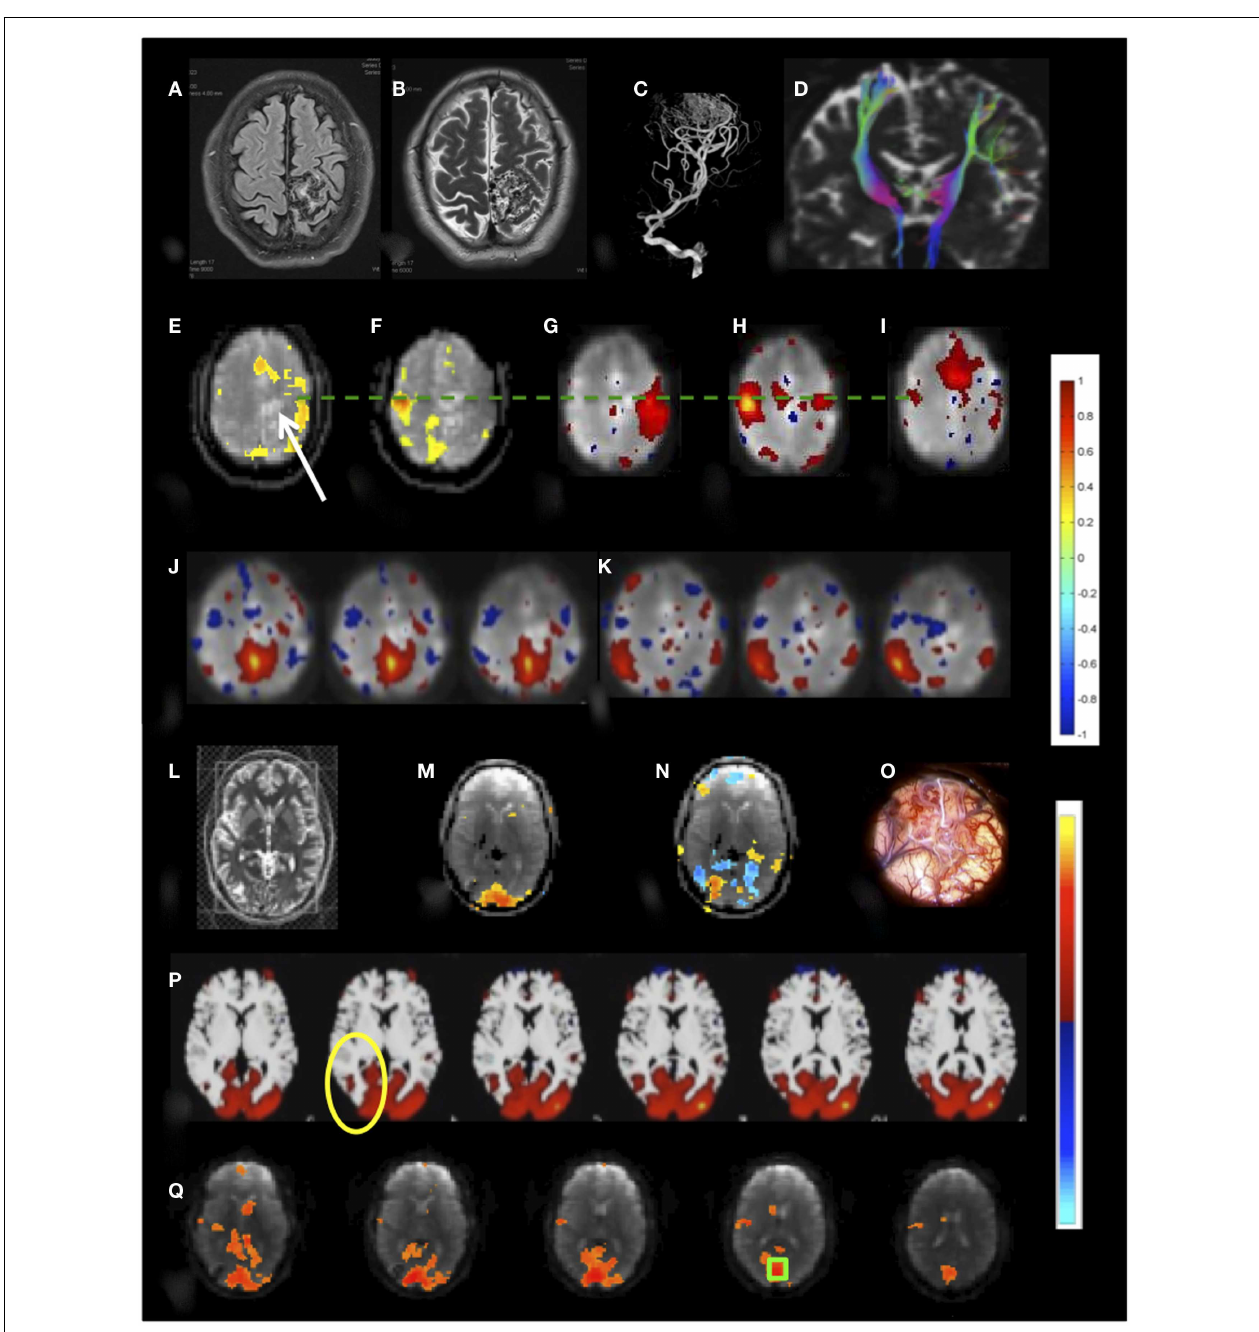
subnetworks (J,K) that do not extend into the left parietal cortex ( z max = 6.2 and 8.5, respectively). Patient 4 with right occipital AVM : (L) T2-weighted MRI.Task-based fMRI using MEPI (TR: 2s). (M) Visual stimulation does not activate the lesion and (N) imagination of the experience of the “aura” associated with epilepsy activates and deactivates areas at the rim of the lesion. (O) Intraoperative image. (P) Resting-state fMRI using MEVI2 (TR: 136ms) and ICA shows a visual RSN that does not extend into the AVM consistent with visual stimulation ( z max = 12.6). (Q) Seed-based functional connectivity of the visual RSN with a seed in BA 17 (green box) does not show visual eloquence within the AVM. Color scales for task-based correlation analysis and seed-based connectivity (top), and ICA (bottom) are shown on the